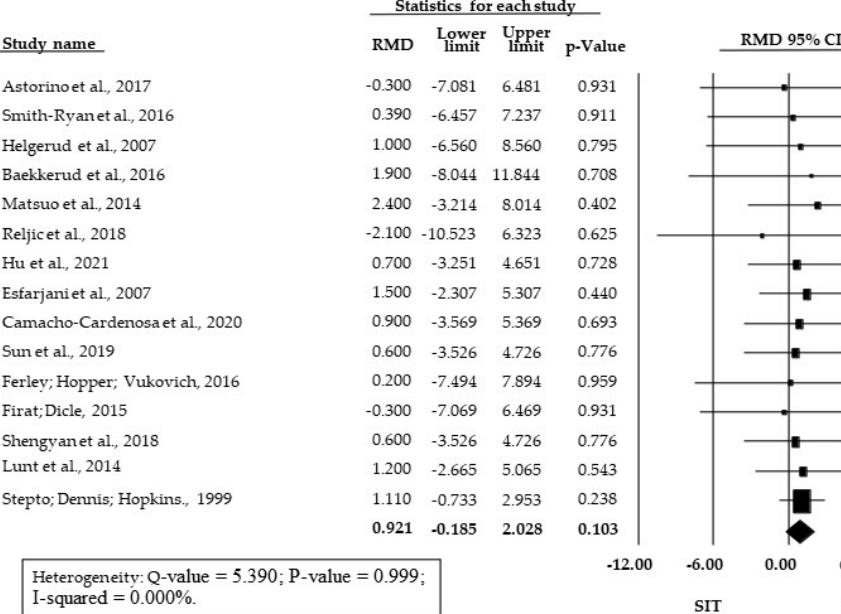
Table 3. Subgroup analysis. Sex